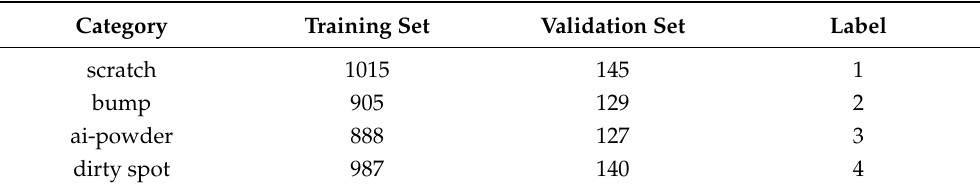
Table 1. Division of dataset of surface defects of aluminum profiles.